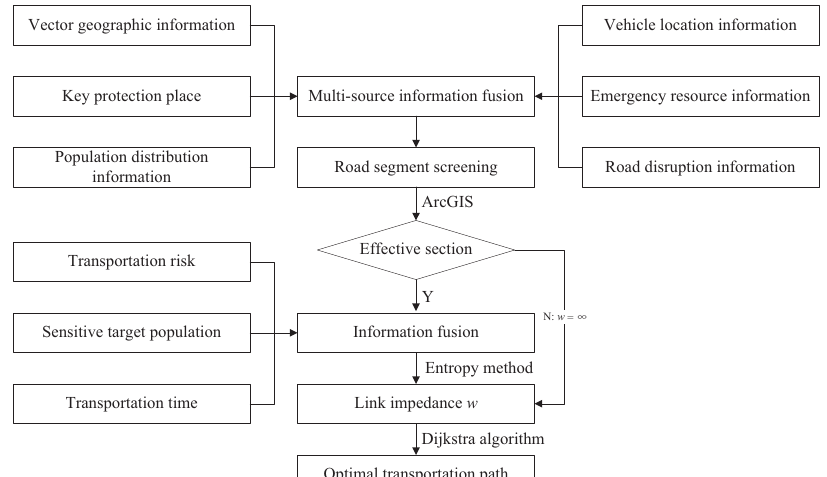
Figure 5 Flow chart of hybrid algorithm for solving optimal transportation path Vector geographic